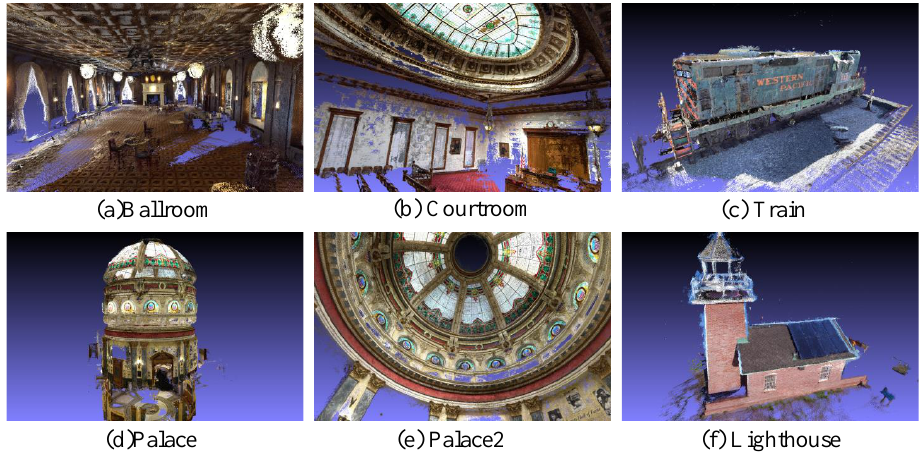
Figure 8. Visualization of the reconstructed point clouds on the Tanks and Temples dataset.